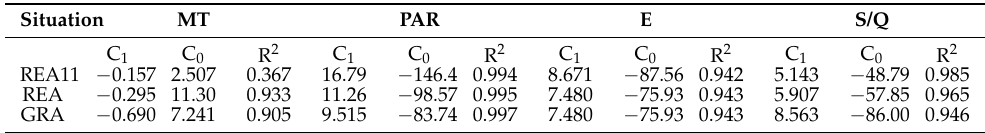
Table 7. The coefficients and R 2 of the fitting lines in responses of O 3 with its driving factors considering monoterpene roles.